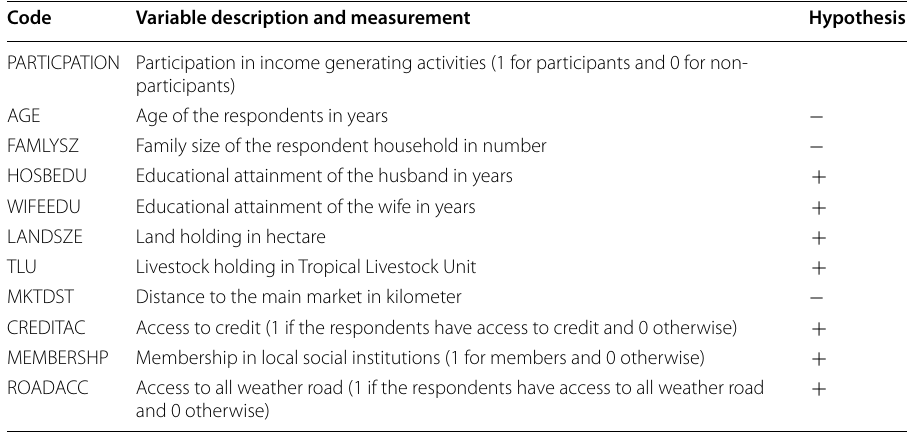
Table 1 Description of variables used in the logit model